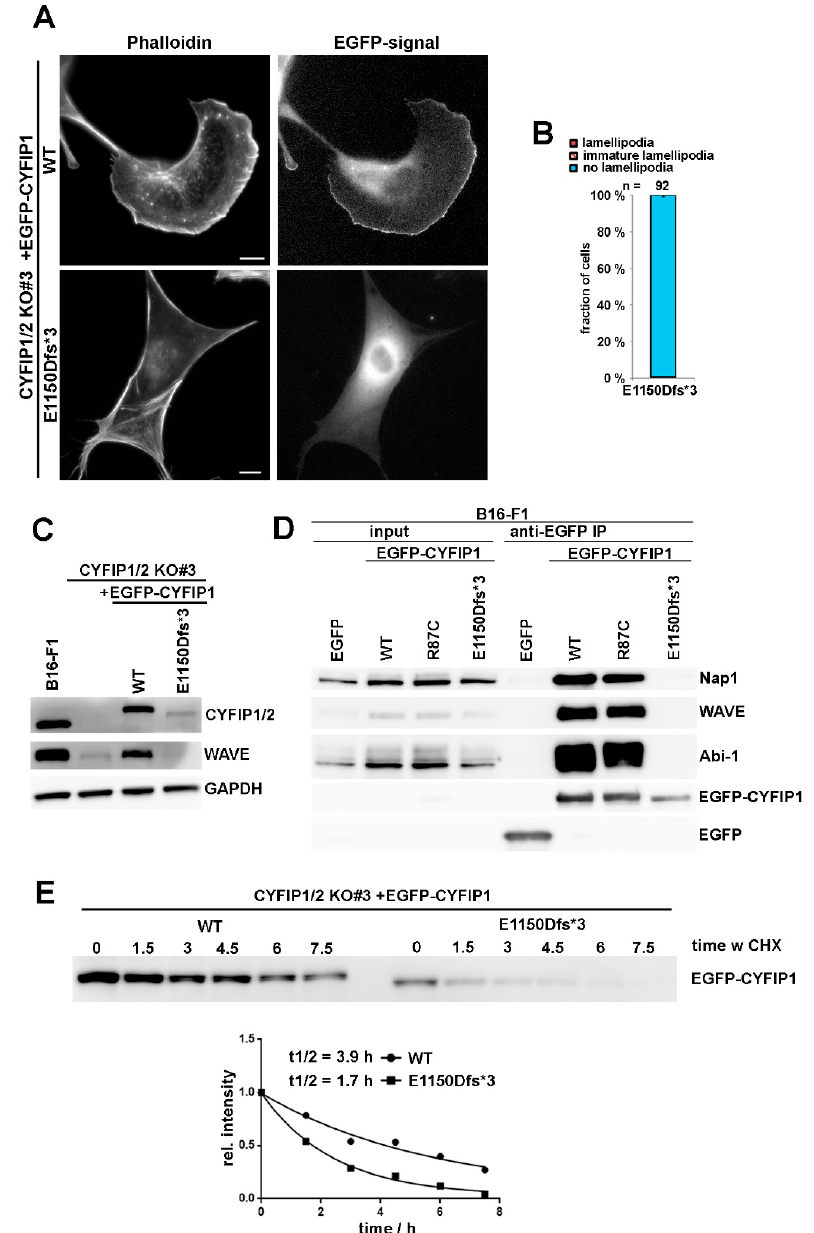
Figure 4. C-terminal truncation of CYFIP prevents WRC assembly and lamellipodia formation. ( A ) Cell morphology of CYFIP1 / 2 KO cells (clone #3) expressing EGFP-tagged WT or E1150Dfs*3 CYFIP1 mutant, leading to a C-terminally, truncated protein. Scale bar, 10 µ m. ( B ) Quantification of lamellipodia formation, done as described for Figure 1A. Note that CYFIP1 WT control is as in Figure 1A. ( C ) Western blotting of B16-F1 cells or CYFIP1 / 2 KO cells (clone #3) transfected with indicated constructs and probed for expression of CYFIP and WAVE. ( D ) B16-F1 cells were transfected with indicated constructs, lysed and subjected to immunoprecipitation analysis to assay interaction of the E1150Dfs*3 mutant of CYFIP1 versus WT or R87C-CYFIP1 with WRC subunits WAVE, Nap1 and Abi-1. ( E ) Cycloheximide treatment of CYFIP1 / 2 KO cells (clone #3) transfected with either WT- or E1150Dfs*3-CYFIP1. Cells were treated with 20 µ g / mL cycloheximide for indicated times (hours), lysed and cell extracts subjected to western blotting against CYFIP1 (top). The decay of protein expression was plotted over time and derived protein half-life estimated. One representative experiment out of two is